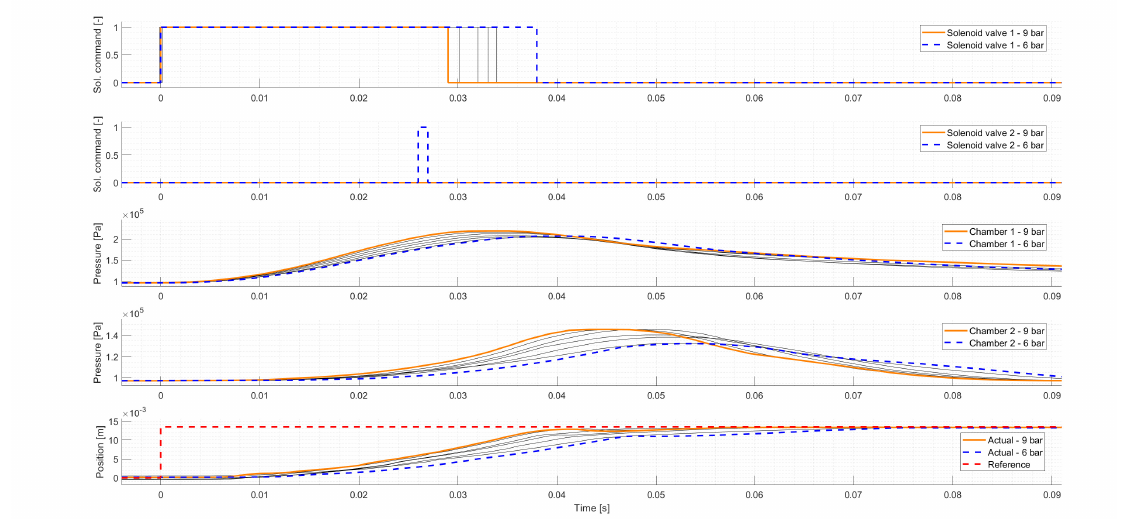
Figure 10. LQR controller—Neutral to High gear changes